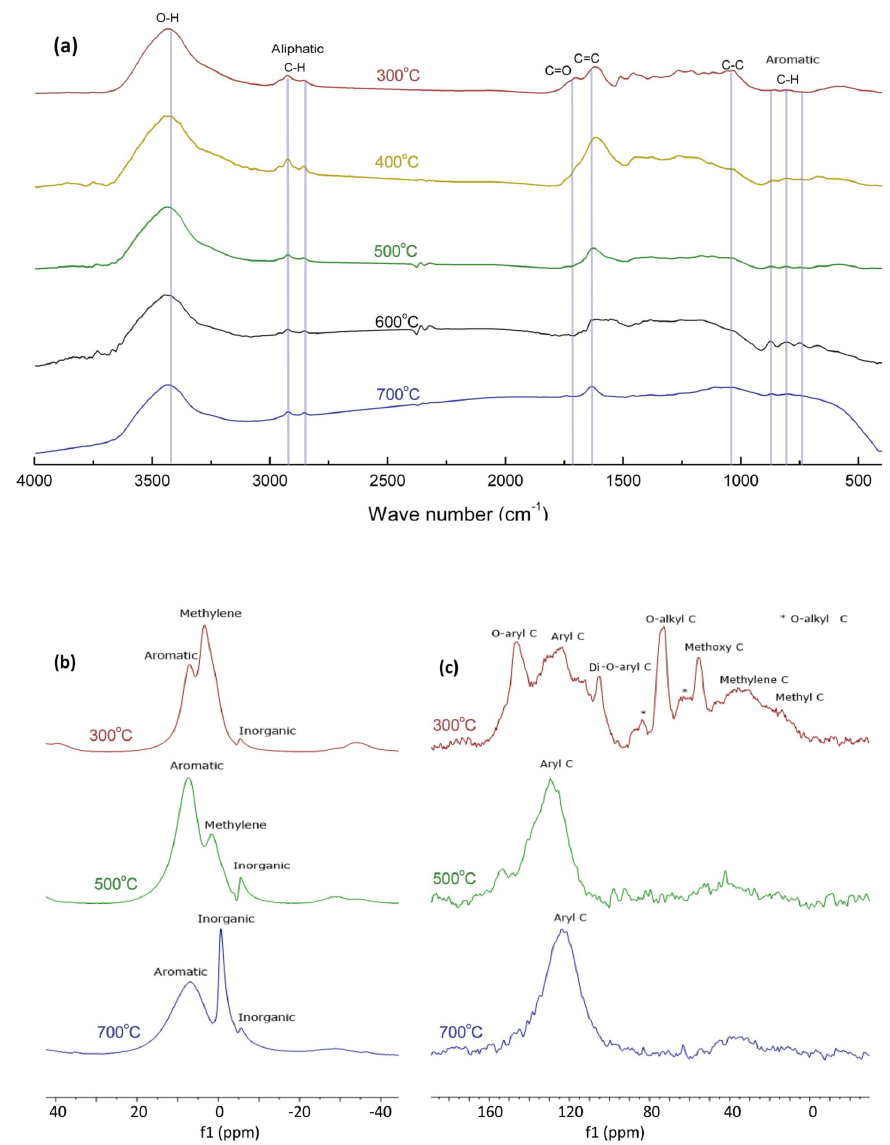
Figure 4. FTIR spectra of Pinus resinosa biochars pyrolyzed at 300 to 700 °C pyrolysis temperatures ( a ); 1 H Nuclear Magnetic Resonance ( 1 H NMR) ( b ) and 13 C Nuclear Magnetic Resonance ( 13 C NMR) ( c ) spectra of Pinus resinosa biochars pyrolyzed at 300, 500, and 700 °C. Both 1 H and 13 C NMR spectra (Figure 4b,c) detected a decrease in the aliphatic carbons and increase in the aryl carbons. In the 1 H NMR spectrum of biochar prepared at 300 °C, the methylene chemical shift at δ = 3.39 ppm decreased in intensity at 500 °C and disappeared at 700 °C. Aromatic chemical shifts at δ = ~7 ppm showed increased intensity at 500 °C and increased broadness at 700 °C. Negative chemical shifts indicate the attachment of inorganic moieties and the high-intensity peak at 700 ° C suggests the presence of carbonates at high concentration. In the 13 C NMR spectrum at 300 °C, numerous carbon signals which are related to the feedstock content (cellulose, lignin) and